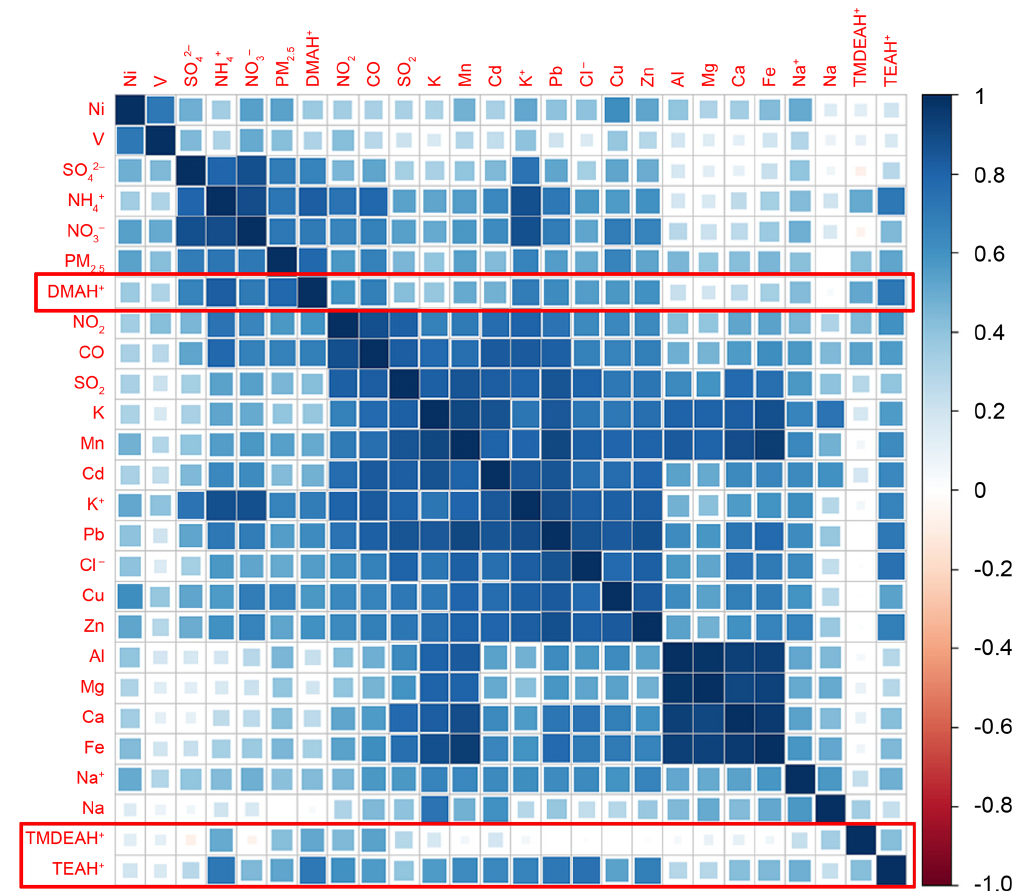
Figure 7. Correlation coefficient matrix among the concentrations of PM 2 . 5 components and gaseous pollutants over Shanghai in